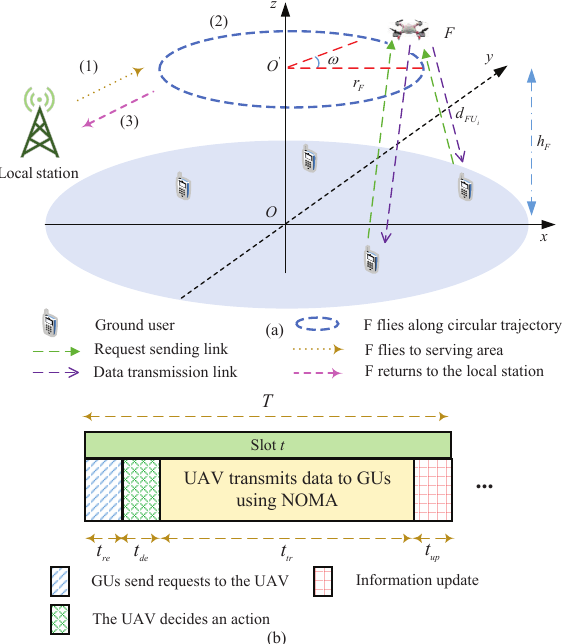
Figure 1. ( a ) The considered network with one UAV (unmanned aerial vehicles) and multiple ground users (GUs). ( b ) The time-frame